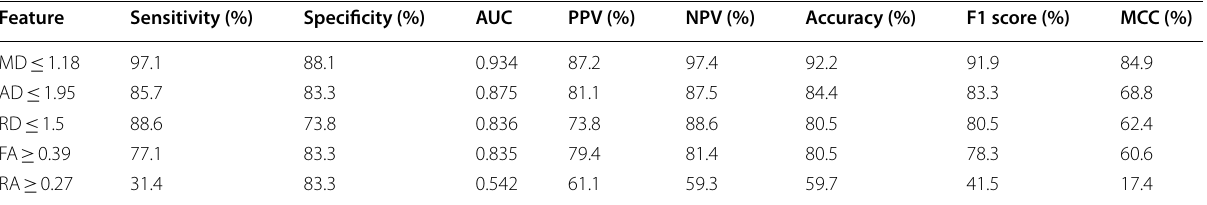
Table 3 Diagnostic performance of DTI parameters in discriminating recurrent breast cancer from postoperative changes